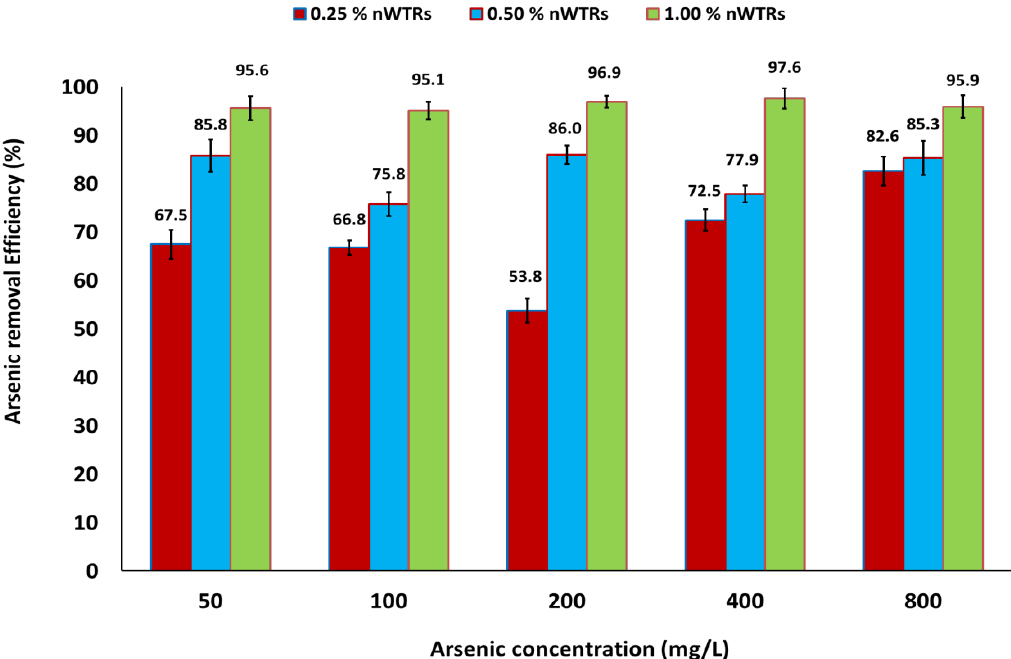
Figure 2. Arsenic sorption efficiency in the calcareous soil amended with biosolids (3%, w/w) and treated with different levels of nWTRs of 0%, 0.25%, 0.5%, and 1% (w/w). Data shown are means and standard deviation (n = 3). The error bars were too small to be visible in the figure.